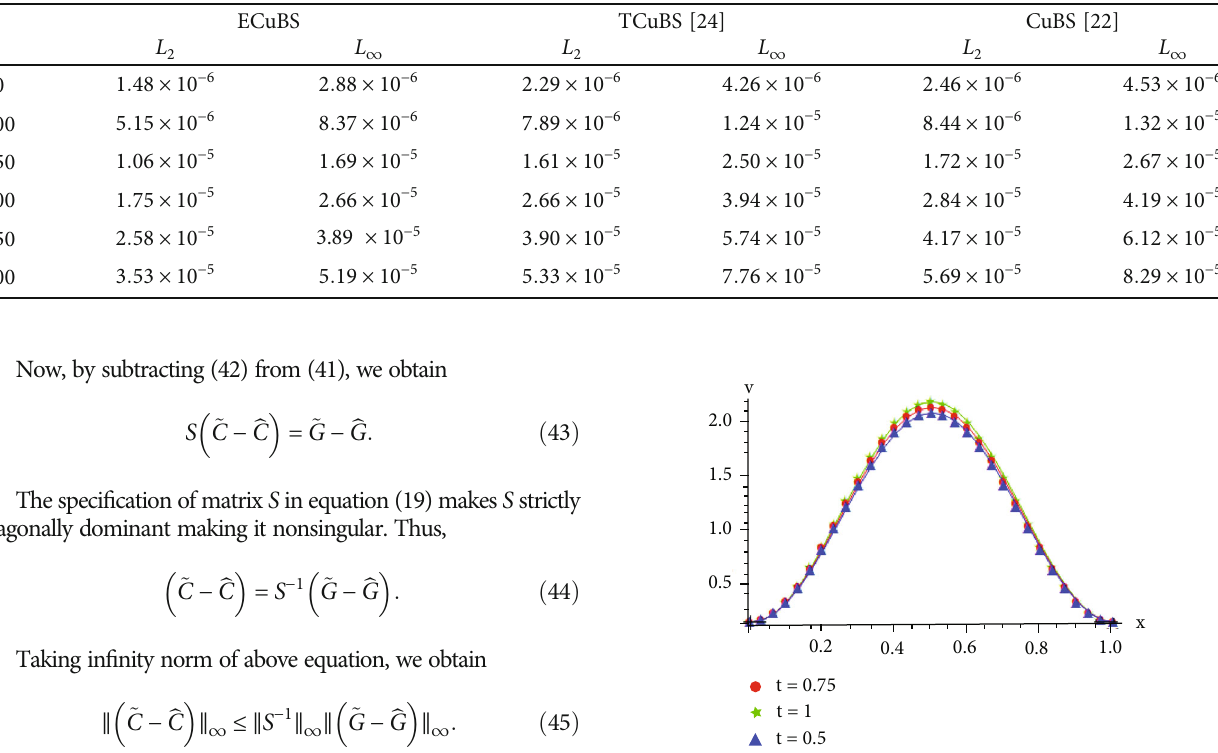
Figure 10: The exact and approximate (triangles, starts, circles) solutions for Example 8 at various times when h = 0 : 01